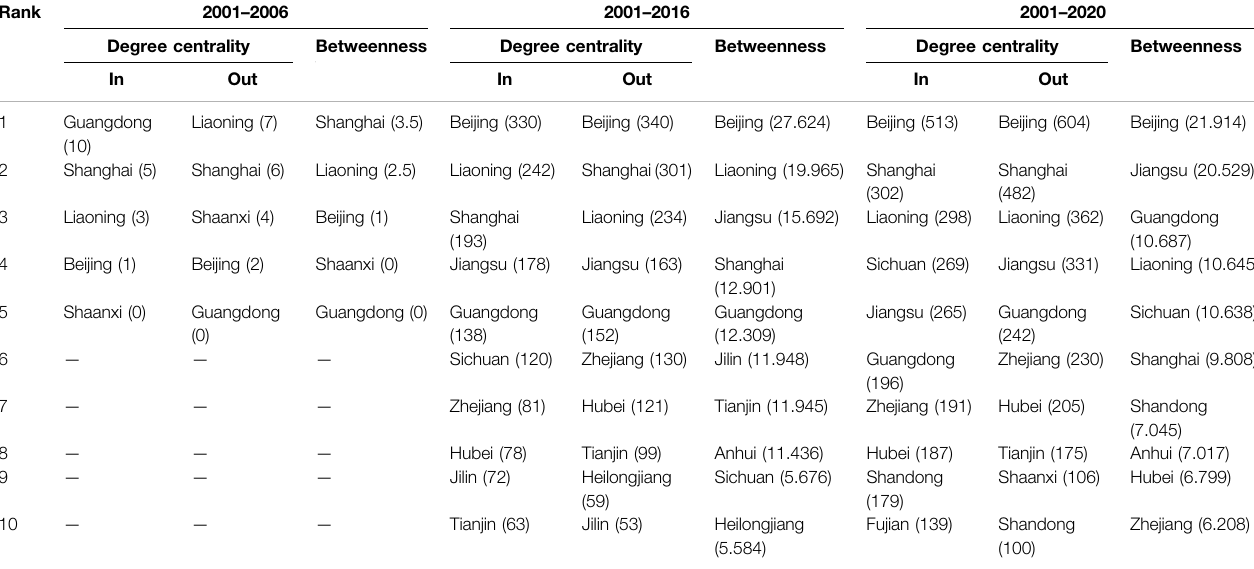
TABLE 5 | Top 10 provinces with the highest centrality in China ’ s HFCV innovation